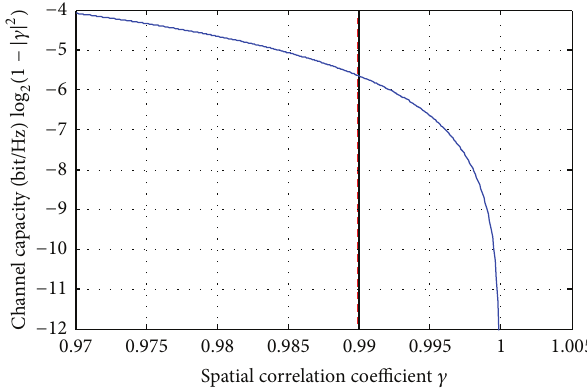
Figure 8: Relation between spatial correlation coefficient and channel